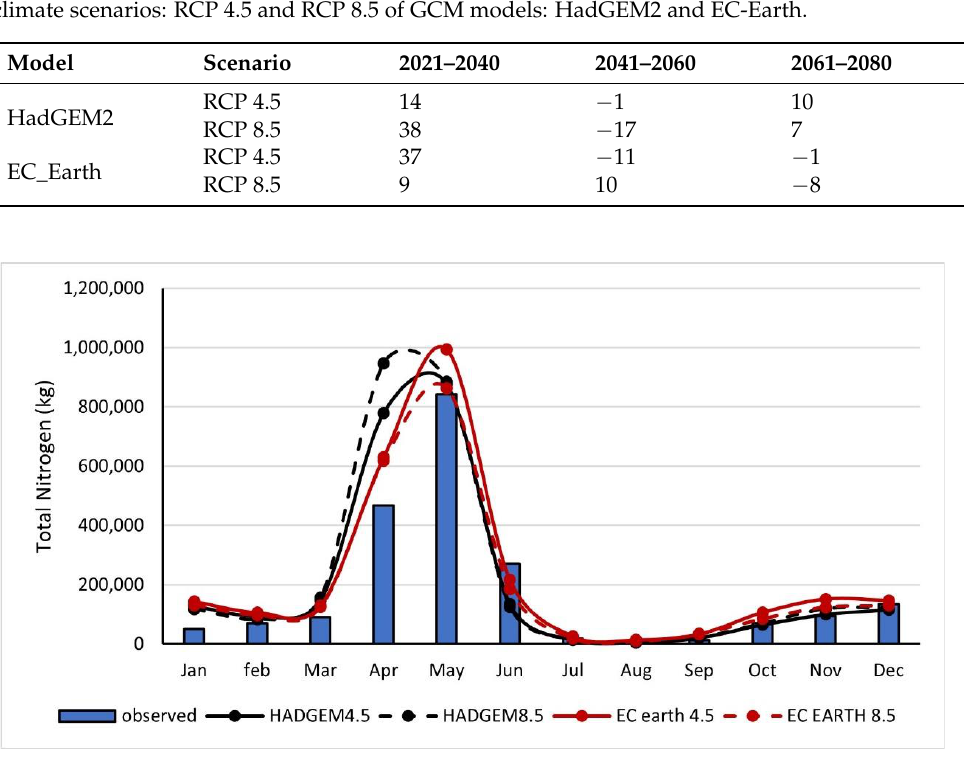
Table 6 . Summary of percentage change in TP load during 2021-2040, 2041-2060 and 2061-2080 for